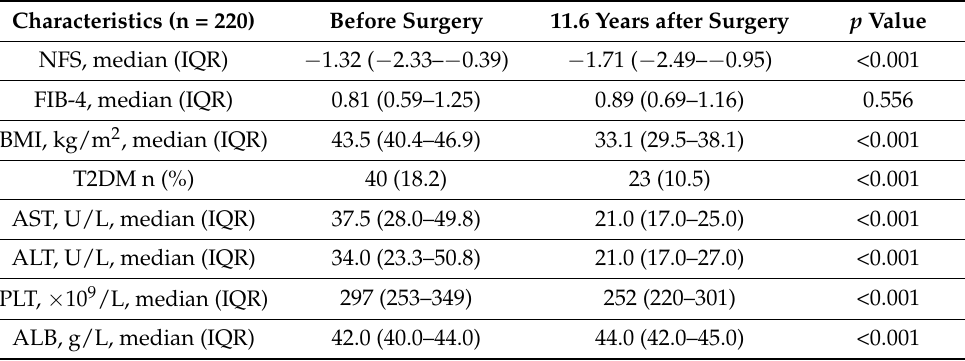
Table 3. Comparison of NFS, FIB-4 and their components before and 11.6 years after Roux-en-Y gastric bypass surgery.